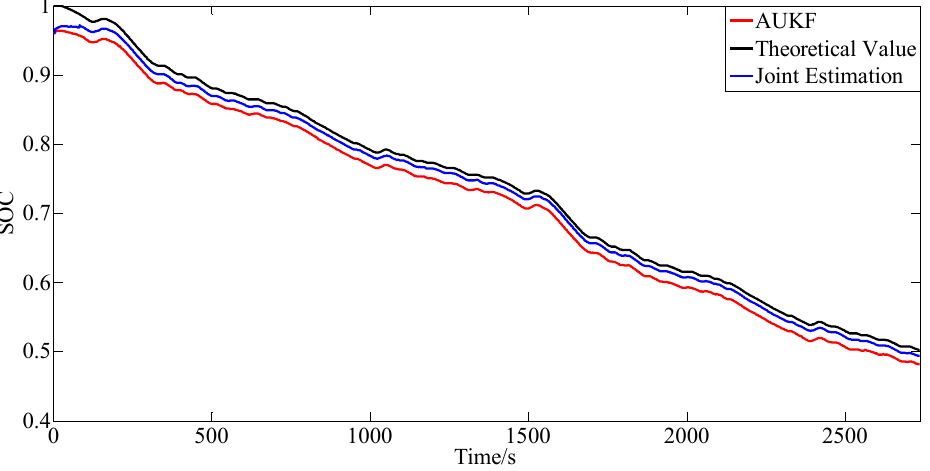
Figure 13. Results of the theoretical value and the two algorithms.